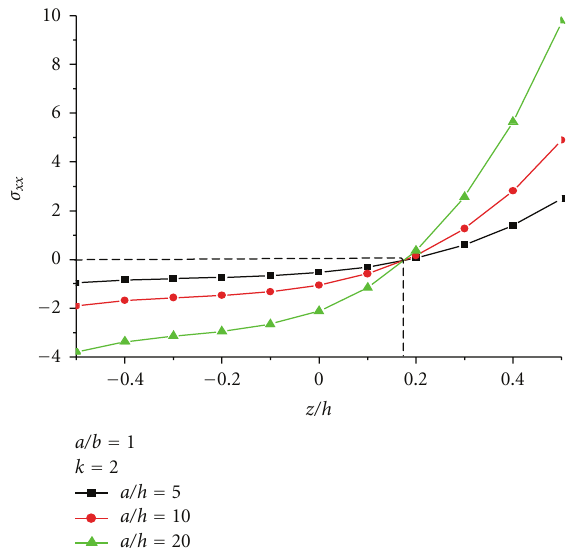
Figure 3: Dimensionless center deflection ( w ) as a function of the side-to-thickness ratio ( a/h ) of an FGM square plate.